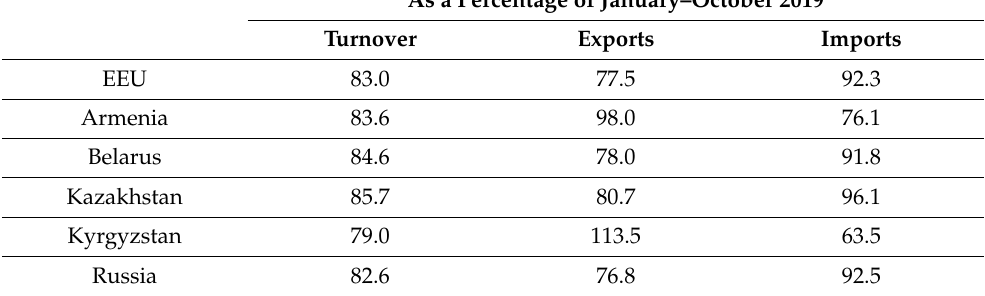
Table 6. Changes in mutual trade in goods between the third countries and the EEU member